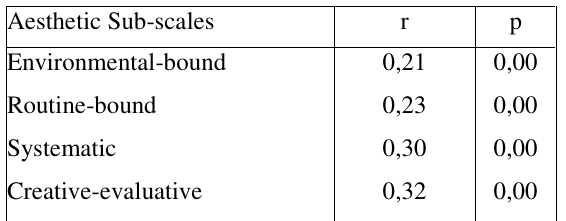
CORRELATION COEFFICIENTS FOR TIME ORIENTATION STYLE AND AESTHETIC